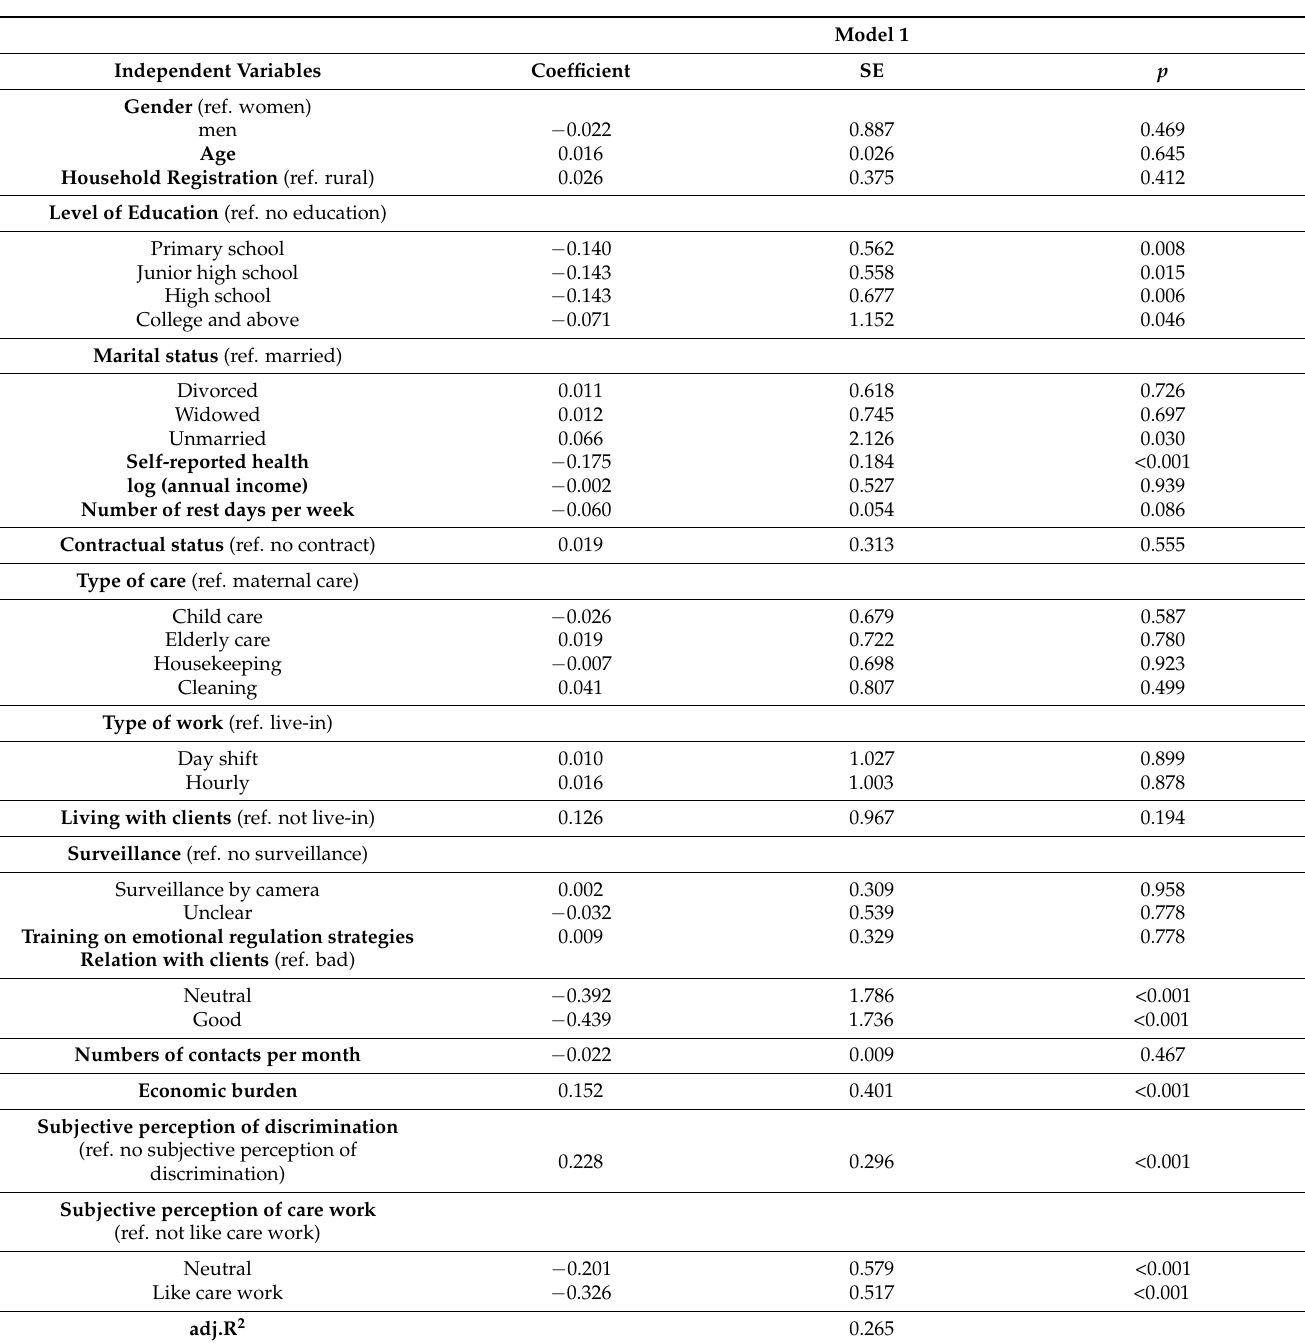
Table 3. Multiple linear regression analysis of home care workers’ depression.